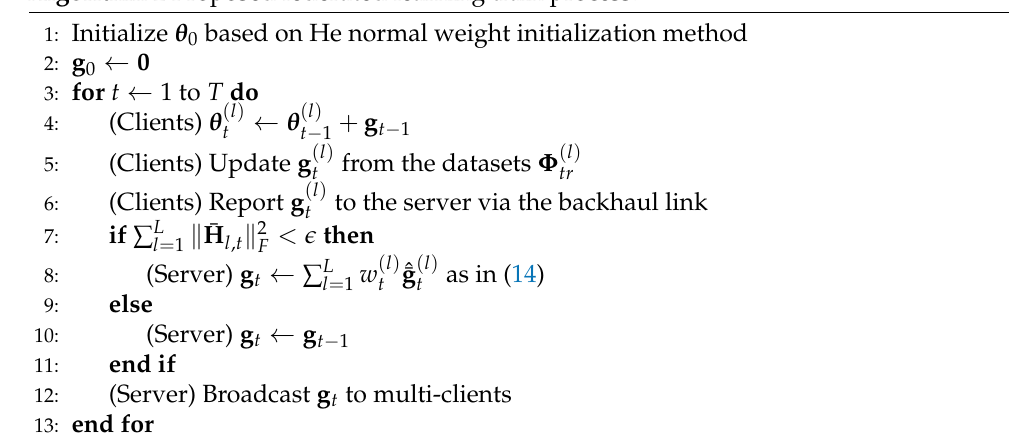
Algorithm 2 Proposed federated learning train